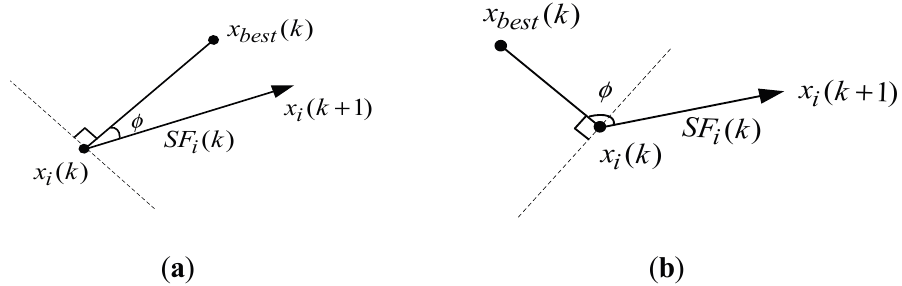
Figure 3. ( a ) Case of enlarging the range of the search step; ( b ) Case of lessening the range of the search